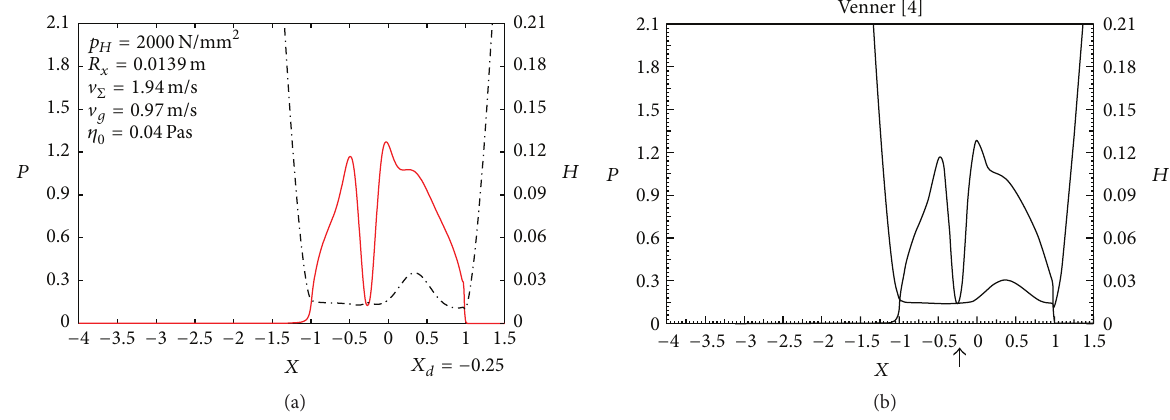
Figure 5: Comparison of simulated pressure and film thickness distribution for a transient isothermal Newtonian EHL contact between the TEHL simulation model of this study (a) and the solution of Venner [4] (b).